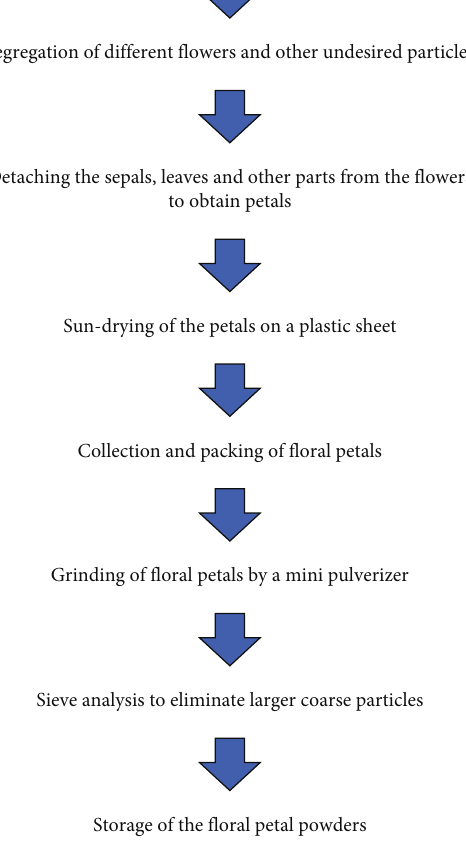
Figure 3: Schematic diagram for the development of fl oral petal